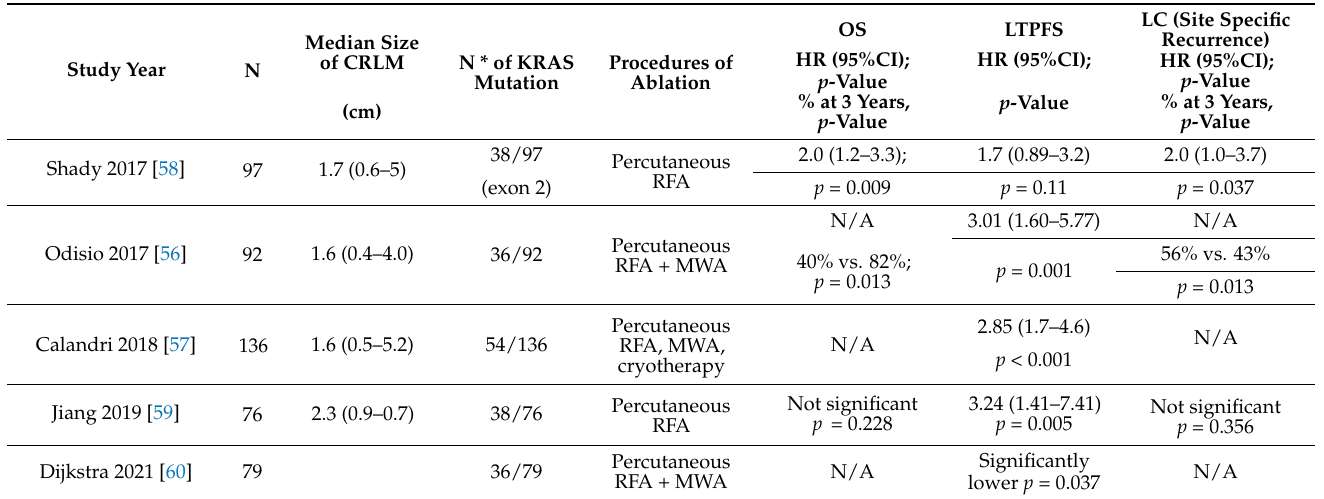
Table 3. Results of studies reporting ablative treatment for colorectal liver metastases according to RAS